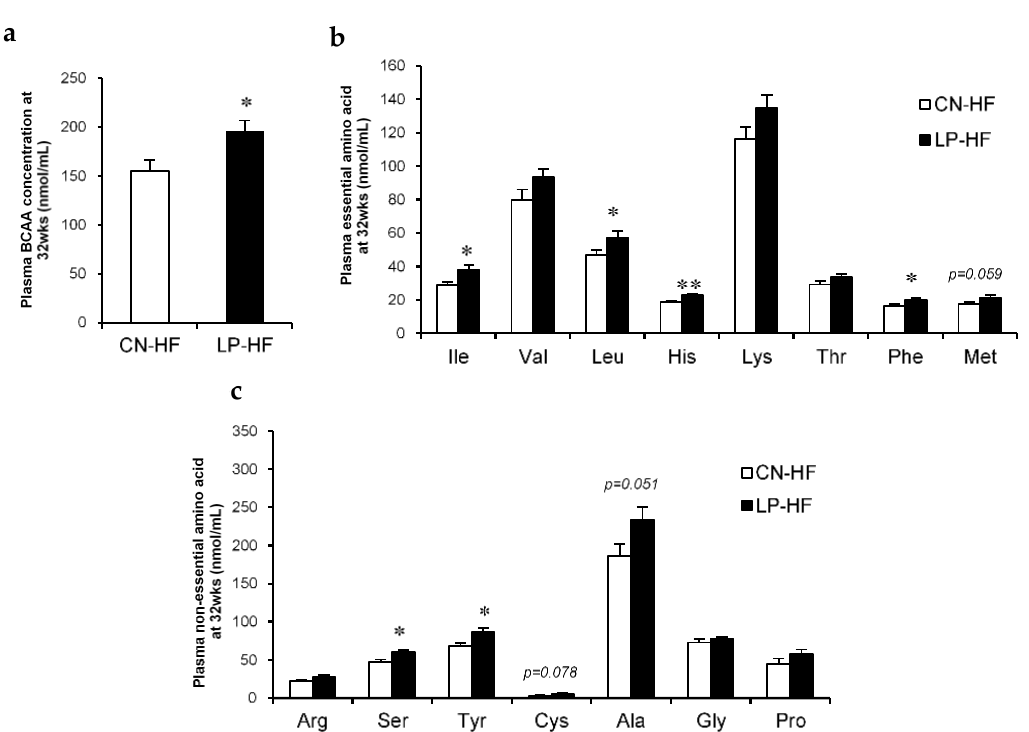
Figure 2. Plasma amino acid concentrations. ( a ) Plasma branched-chain amino acid (BCAA) con-